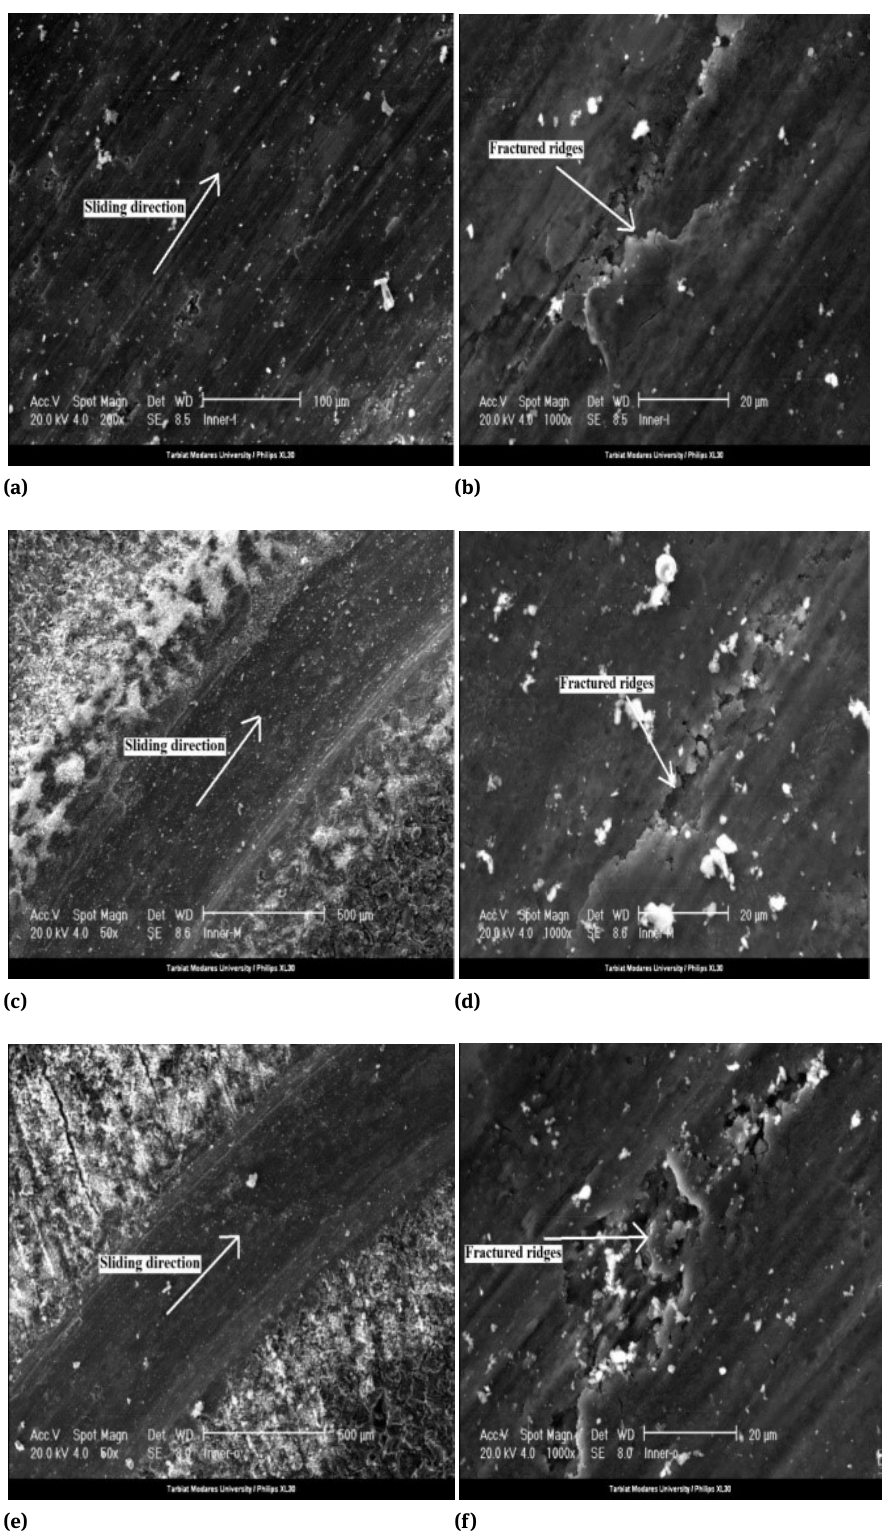
Figure 12: SEM Philips XL30 micrographs of worn surfaces of specimens at the end of wear test, carried out at linear sliding velocity (S V ) of 6.35 Cm.s −1 and under fixed normal load ( F N ) of 40 kN in different test sections (a) and (b) sliding direction and sub-surface cracking for section 0-4 mm away from inner edge of FGM cylinder, respectively, (c) and (d) sliding direction and sub-surface cracking for section 4- 8 mm away from inner edge of FGM cylinder, respectively, (e) and (f) sliding direction and sub-surface cracking for section 8-12 mm away from inner edge of FGM cylinder,